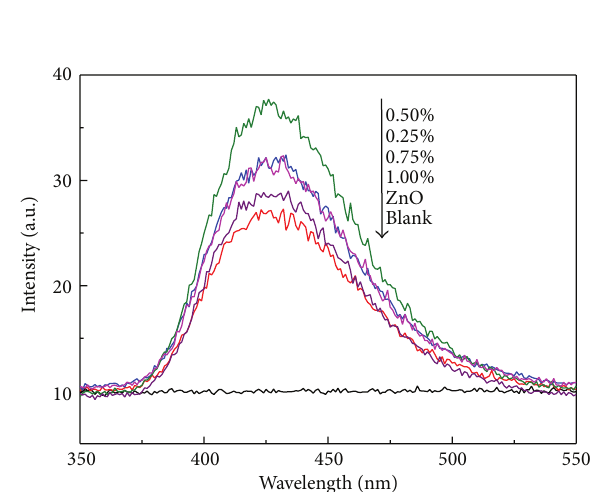
a Surface concentration of different O states is in parentheses.